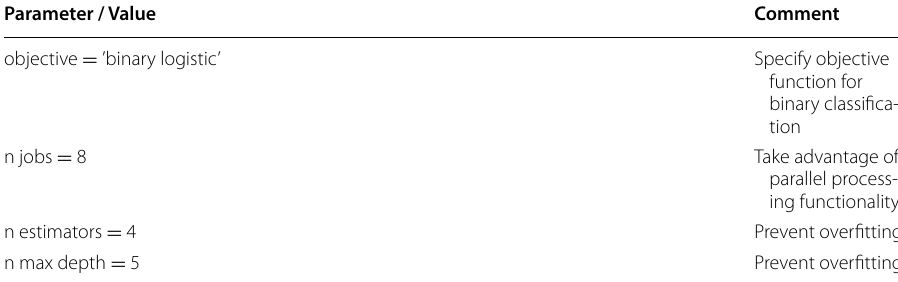
Table 3 XGBoost classifier hyper-parameters